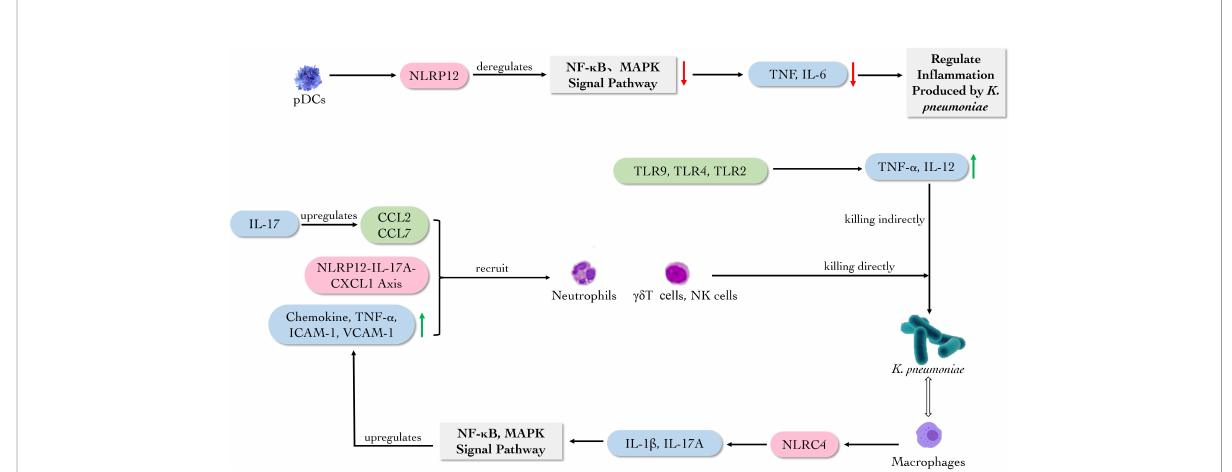
FIGURE 6 The main role of immune molecules against K. pneumoniae . pDCs secrete NLRP12 participating NF- к B and MAPK signal pathways to regulate the in fl ammation caused by K. pneumoniae . While TLR2, TLR4 and TLR9 promote the production of TNF- a and IL-12. Macrophage-derived NLRC4 induces the production of IL-1 and IL-17A in lung, activating NF- k B and MAPK signal pathways to upregulate the production of chemokine, TNF- a , ICAM-1 and VCAM-1, which can recruit neutrophils. Meanwhile, NLRP12-IL-17A-CXCL1 axis, CCL2 and CCL7 recruit neutrophils, gd T cells and NK cells to eliminate K. pneumoniae